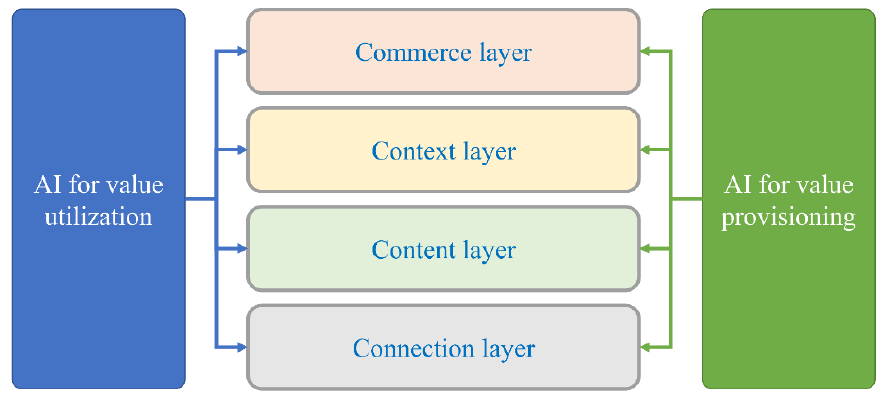
Figure 1. The simplified overall conceptual framework of the study.